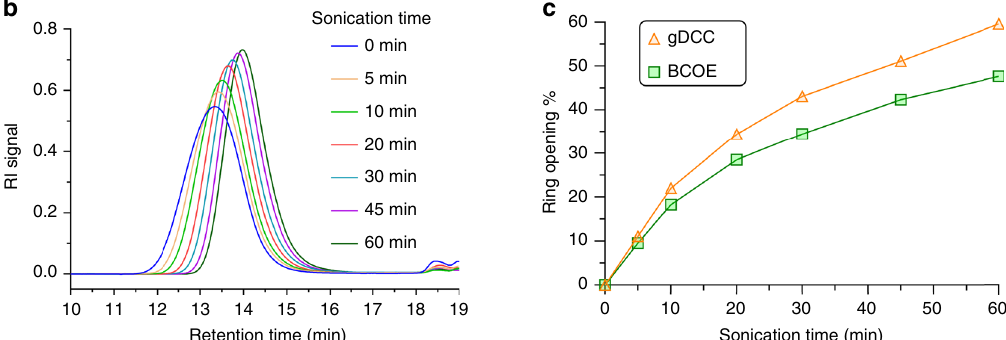
Fig. 4 Ultrasonication study of polymer P2. a Schematic presentation of ultrasonication induced mechanical activation of BCOE and g DCC in P2 , and the 1 H NMR characterization of activated species in P2 . b Evolution of GPC traces of P2 over ongoing sonication time. c Fraction of activated BCOE and g DCC at various sonication time. The fraction of activated BCOE was calculated using peak f, which corresponds to two protons in activated BCOE (Supplementary Fig.